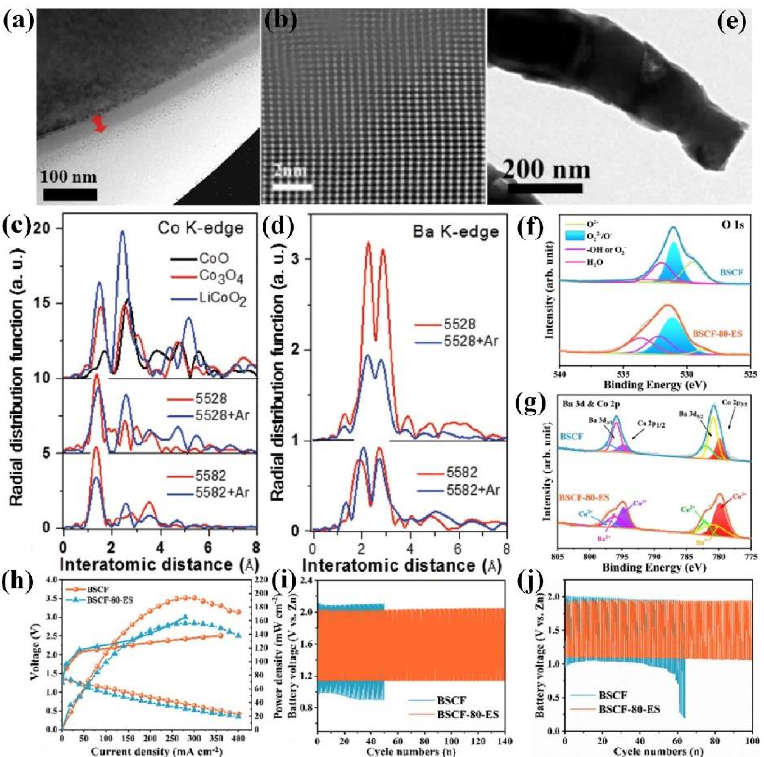
Figure 5. ( a , b ) TEM and STEM images of Ba 0.5 Sr 0.5 Co 0.2 Fe 0.8 O 3−δ ; ( c , d ) Co, Ba K-edge EXAFS spectra [92]. Copyright 2015, Wiley-VCH; ( e ) TEM image of Ba 0.5 Sr 0.5 Co 0.2 Fe 0.8 O 3−δ ; ( f , g ) XPS O 1s and Co 2p regions; ( h ) power density; ( i , j ) the stability of aqueous ZABs and flexible ZABs [99]. Copyright